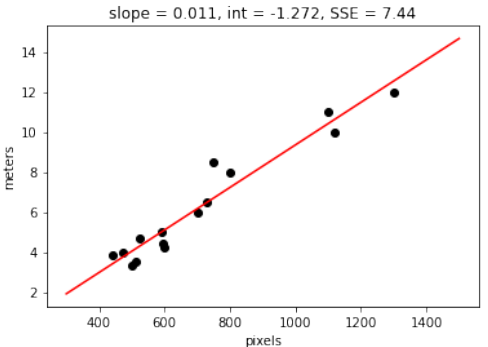
Figure 4. Linear regression for transforming pixels to